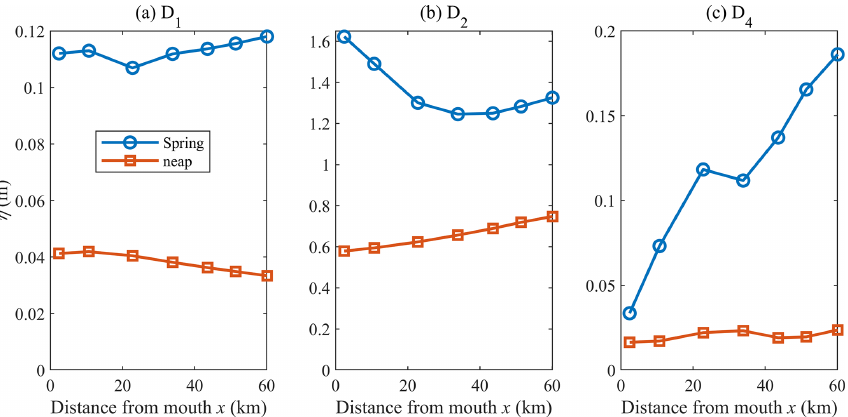
Figure 7. Amplitude ( η ; metres) of the (a) diurnal D 1 (b) semi-diurnal D 2 , and (c) quarter-diurnal D 4 tidal species along the channel during the largest spring (blue line; 31 August 2015) and lowest neap (red line; 24 August 2015)